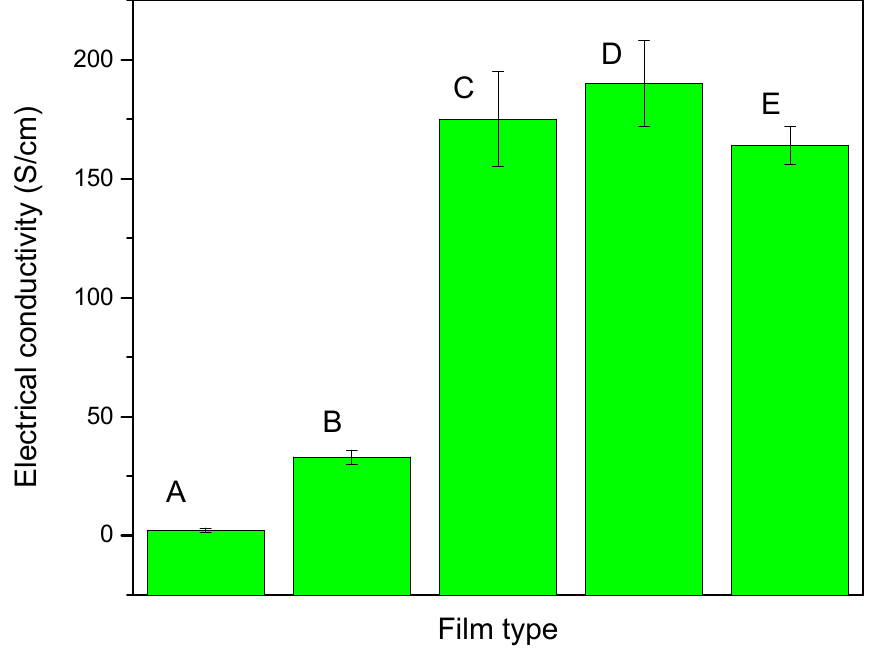
Figure 4. The electrical conductivity of ( A ) pure PEDOT:PSS film; ( B ) NMP doped PEDOT:PSS film; ( C ) GNPs type 1 + NMP doped PEDOT:PSS composite film; ( D ) GNPs type 2 plus NMP doped PEDOT:PSS film and ( E ) GNPs type 3 + NMP doped PEDOT:PSS composite